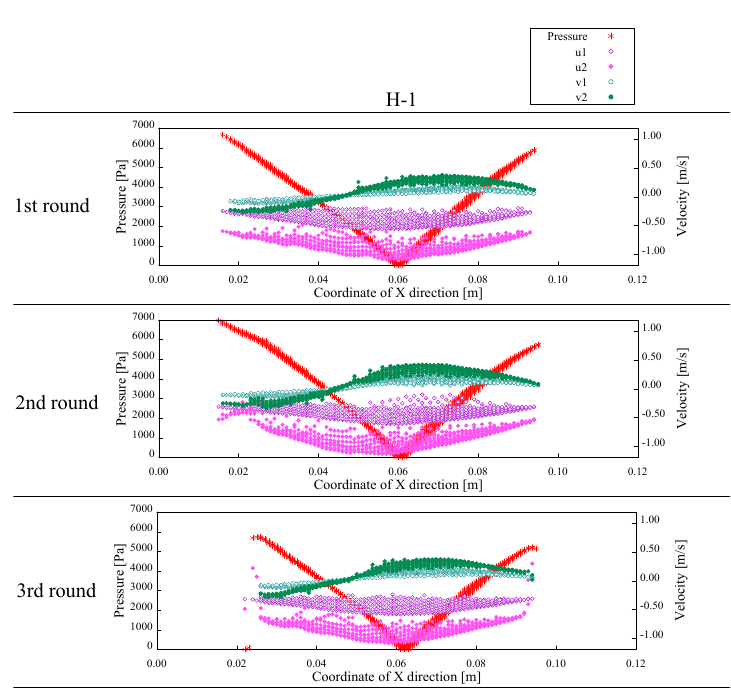
Figure 22. Comparison of the values of the pressure and flow velocity from the simulation results of H-1.